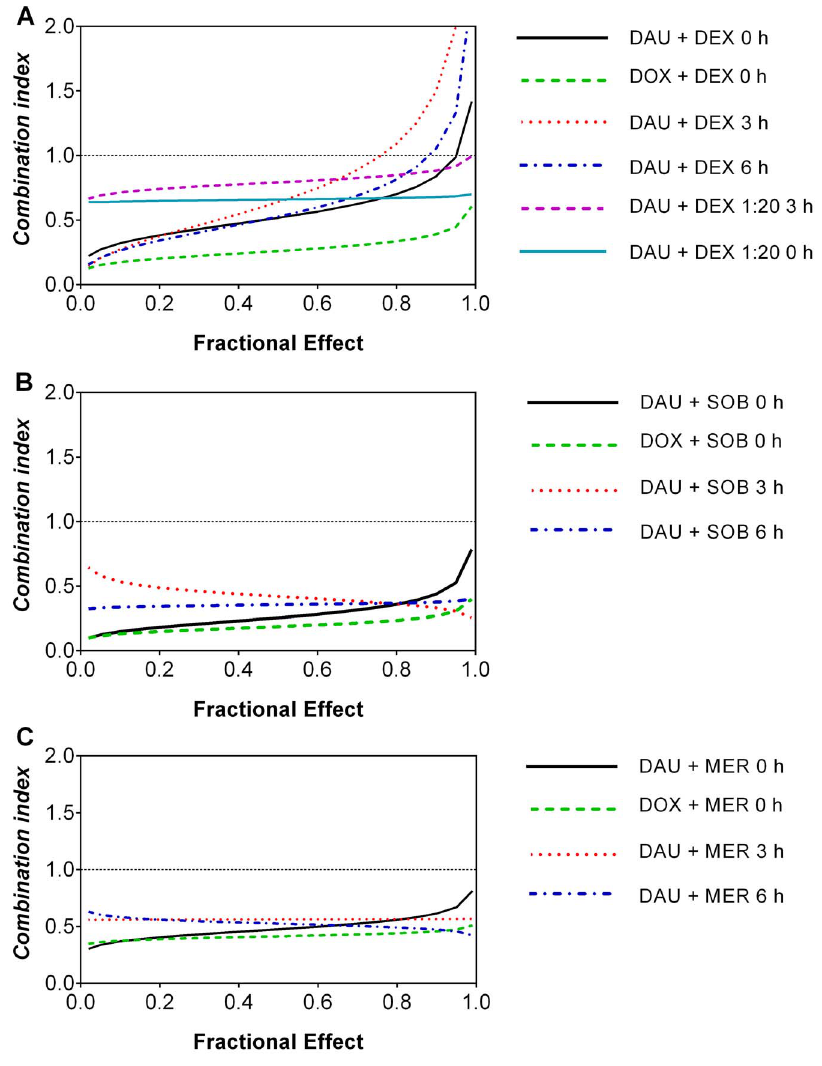
Figure 4. Effects of dexrazoxane, sobuzoxane or merbarone and daunorubicin or doxorubicin on the proliferation of HL-60 cell line. Cells were incubated either continuously with dexrazoxane (DEX, A), sobuzoxane (SOB, B) or merbarone (MER, C) and daunorubicin (DAU) or doxorubicin (DOX) for 72 h or pre-incubated with DEX (A), SOB (B) or MER (C) for 3 h or 6 h and then incubated for 72 h with all drugs at concentrations corresponding to their IC 50 values and IC 50 fractions and multiples (1/8; 1/4; 1/2; 1; 2; 4). Alternatively, cells were either co-incubated for 72 h or pre-incubated with DEX for 3 h and then co-incubated with DAU for 72 h at a ratio of 1:20 DAU:DEX (A). Computer simulations of combination index ( CI ) - cellular proliferation (fraction affected - Fa ) dependences were obtained using CalcuSyn 2.0